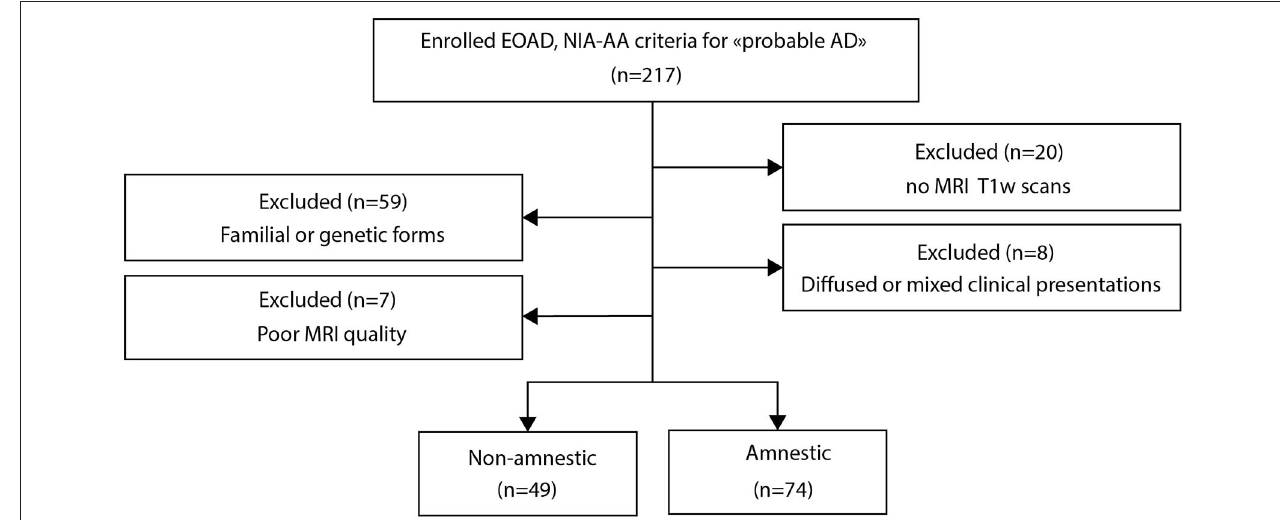
FIGURE 1 | Flowchart of the study